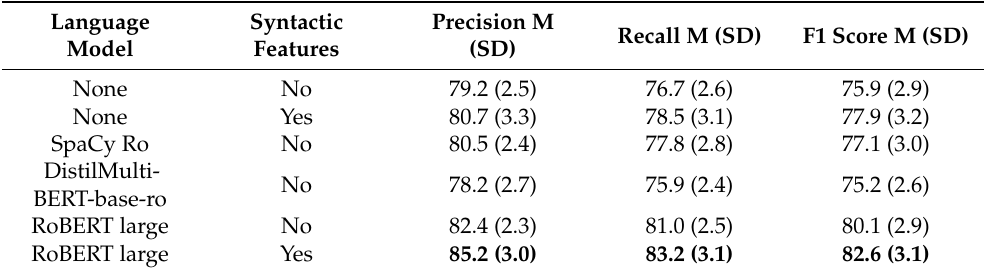
Table 2. Comparison of NLU pipeline variations for intent classification (bold denotes the best performance).